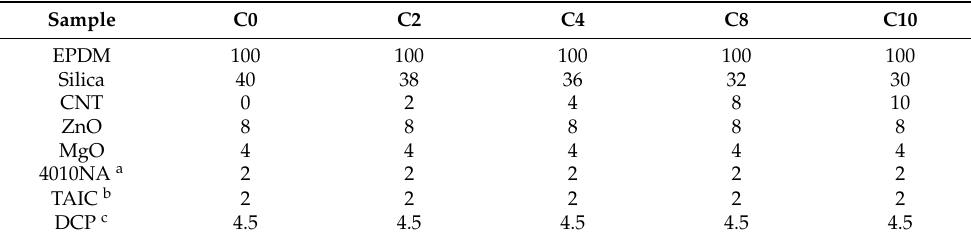
Table 1. Recipe of EPDM/silica/CNTs composites (unit: per hundred rubber, phr).